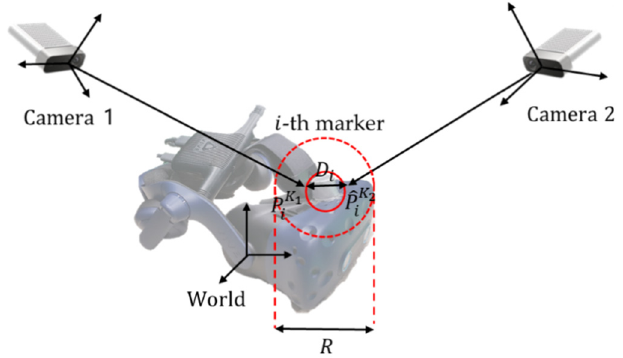
Figure 5. Error measurement between two Kinect captures: Here, 𝑃 (cid:3036)(cid:3012) (cid:3117) and 𝑃(cid:3552) (cid:3036)(cid:3012) (cid:3118) are a marker posi- tion and a calibrated marker position in the world coordinate, respectively, for the 𝑖 -th marker after slope correction of